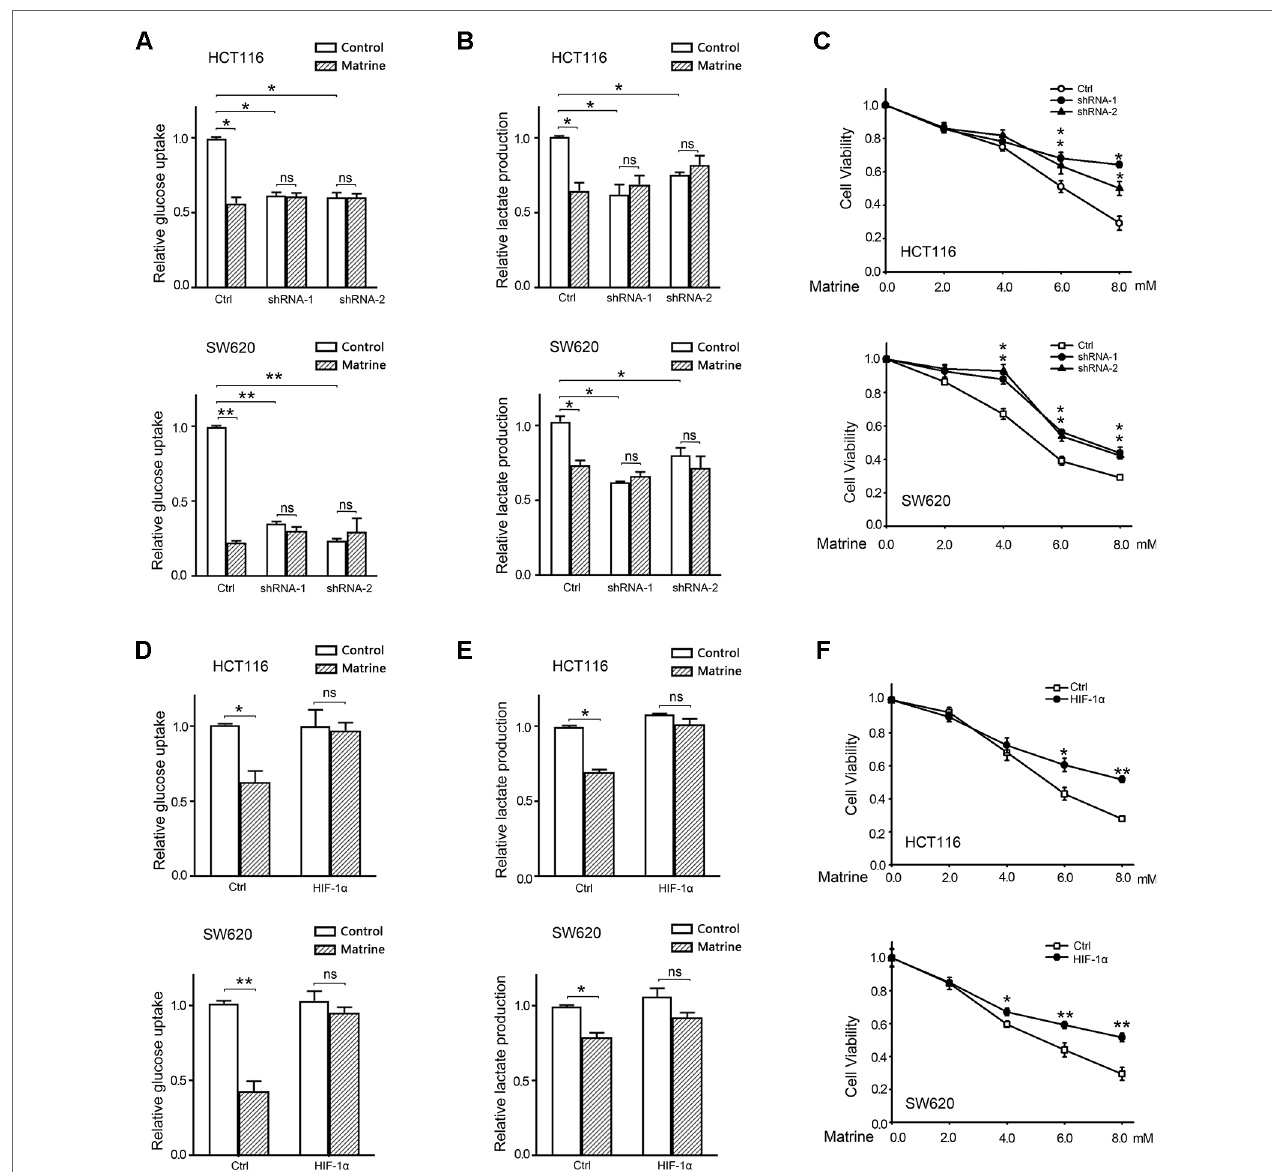
FIGURE 5 | The growth inhibitory effect of matrine is attenuated by knockdown or overexpression of HIF-1α. (a) Quantified data of glucose uptake determined by flow cytometry in HCT116 and SW620 cells after 4.0 mM matrine treatment for 48 h. Data were expressed as mean ± SEM, n = 3. *, P < 0.05, **, P < 0.01, ns: not significant. (B) Lactate production of HCT116 and SW620 cells with the 4.0 mM matrine treatment for 24 h. Data were expressed as mean ± SEM, n = 3. *, P < 0.05, ns: not significant. (C) Cell viability accessed by 3-(4,5-dimethylthiazol-2-yl)-2,5-diphenyltetrazolium bromide (MTT) assay after treatment with 0~8.0 mM matrine for 12 h. Data were expressed as mean ± SEM, n = 3~5, * P < 0.05. (D) Quantified data of glucose uptake determined by flow cytometry in HCT116 and SW620 cells after 4.0 mM matrine treatment for 48 h. Data were expressed as mean ± SEM, n = 3. *, P < 0.05, ns: not significant. (E) Lactate production of HCT116 and SW620 cells with the 4.0 mM matrine treatment for 24 h. Data were expressed as mean ± SEM, n = 3. *, P < 0.05, ns: not significant. (F) Cell viability accessed by MTT assay after treatment with 0~8.0 mM matrine for 12 h. Data were expressed as mean ± SEM, n = 3~5, * P < 0.05, **, P <